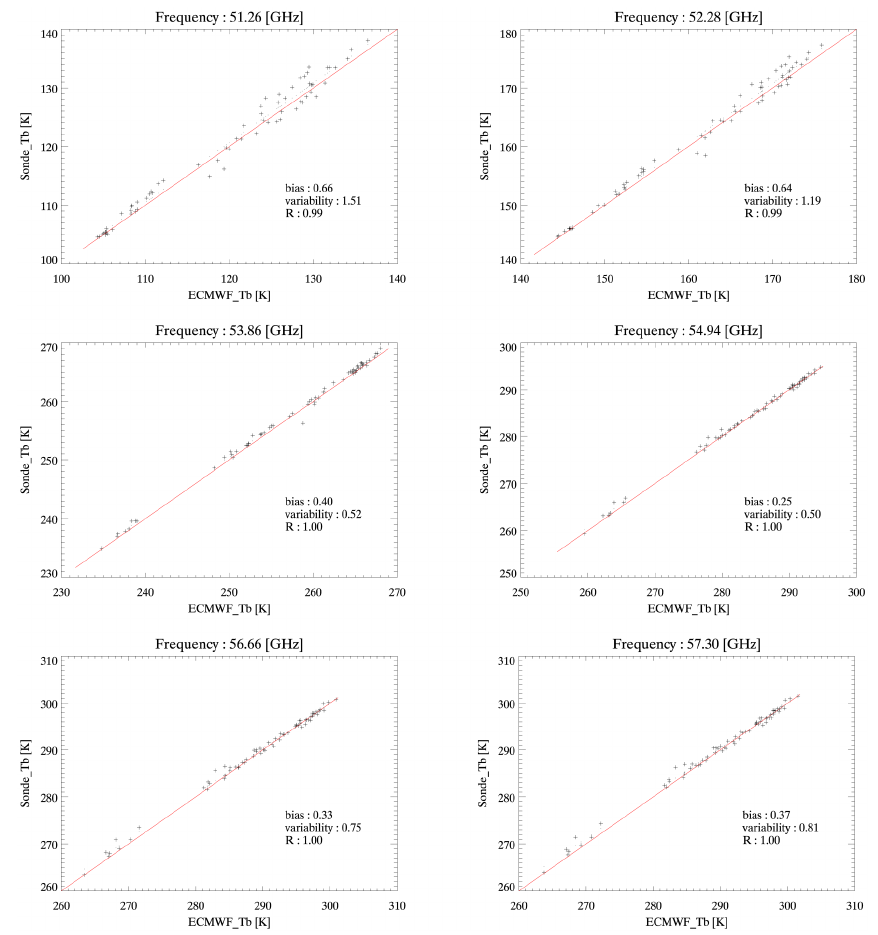
Figure 2. Scatter diagram between the simulated T b using ECMWF data ( T E